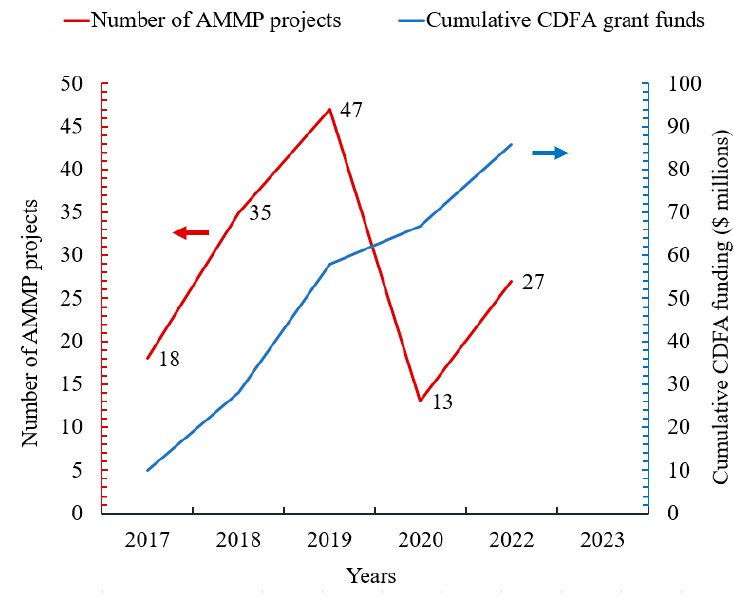
Figure 7. Number of digester projects and total funding for the